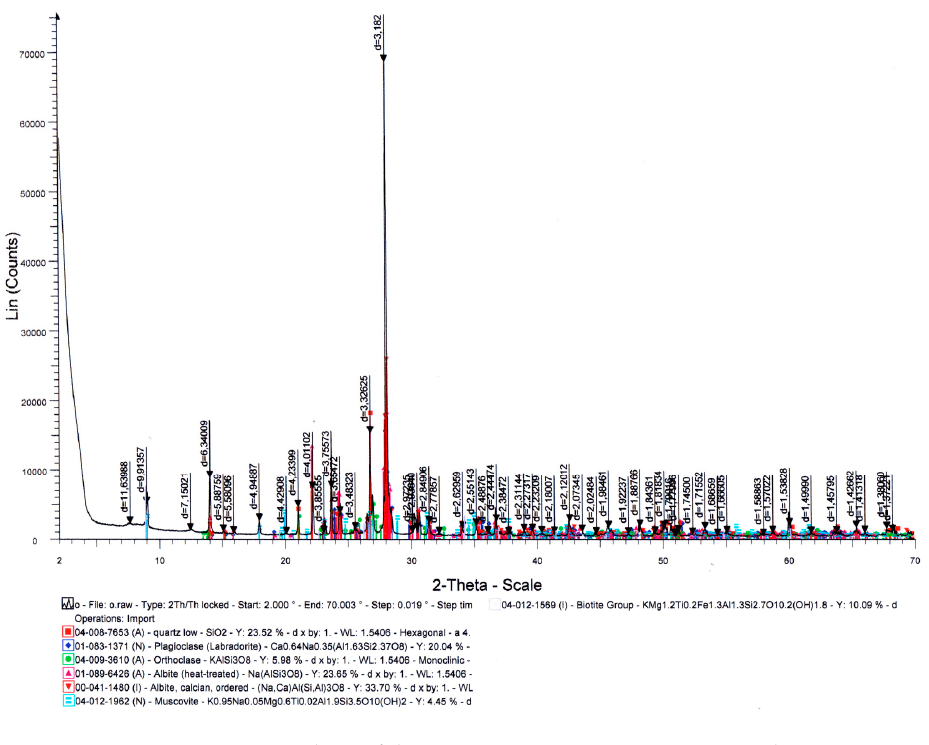
Figure 1. XRD analysis of the representative Augen-Gneiss sample.